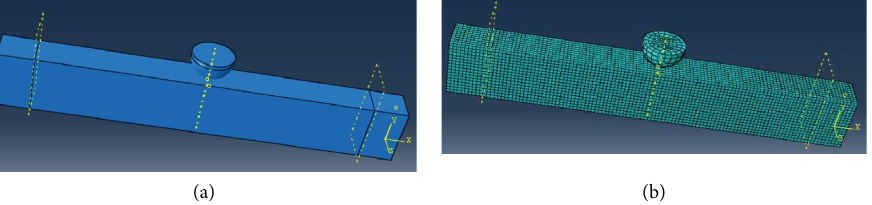
Figure 2: (a) Finite element model of RC dapped beam and (b) mesh and discretized FEM of reinforced concrete dapped-end beam.